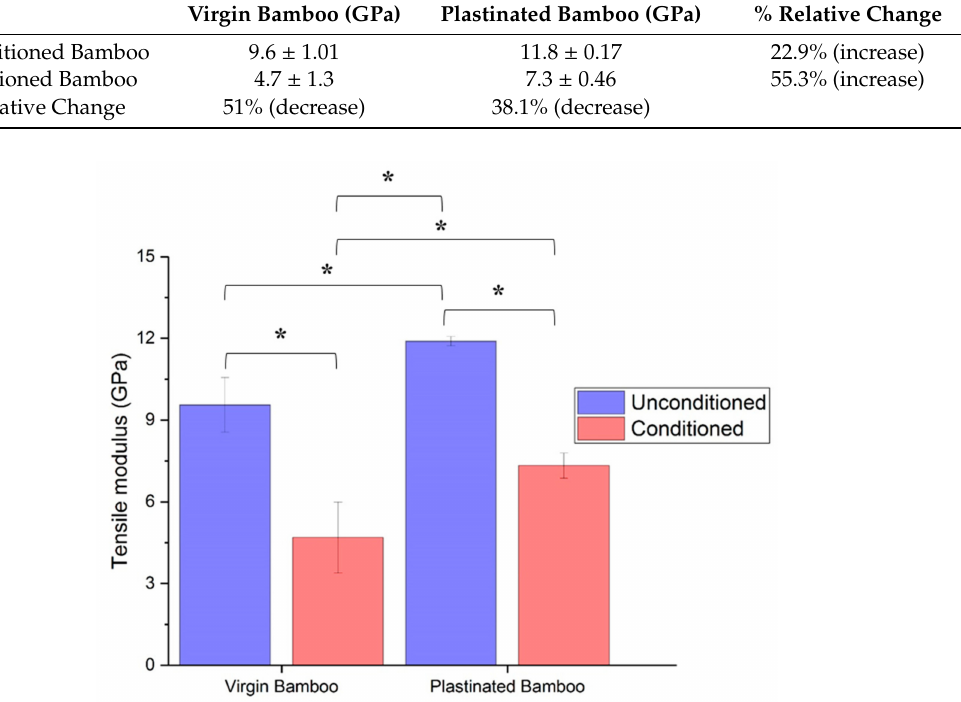
Figure 8. Tensile modulus of virgin and plastinated bamboo before and after moisture conditioning. * indicates a significance level with p -value <